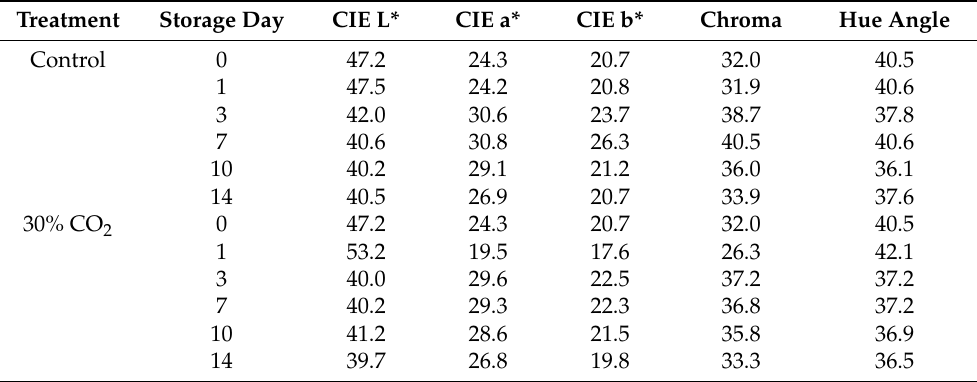
Table 1. Effects of 30% CO 2 treatment for 3 h on the peel color (L*, a*, b*), chroma, and hue angle of strawberry fruits ( Fragaria × ananassa Duch. ‘Seolhyang’).